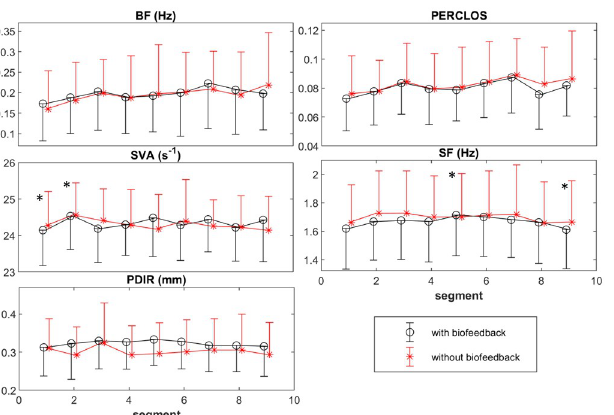
Fig 10. The changes through TOT in the oculometrics, i.e. Blink Frequency (BF), Percentage of the duration of closed eyes to opened eyes (PERCLOS), Saccade Peak Velocity Amplitude Relationship (SVA), Saccade Frequency (SF), Pupil Diameter Interquartile Range (PDIR) used in the deployed model in the automatic (with biofeedback) sessions and manual (without biofeedback) sessions. The points and error bars respectively represent the mean and standard deviation values across the participants for each segment. The segments with significant differences according to the pairwise comparisons are marked by “ � ”, ( p < 0.05).